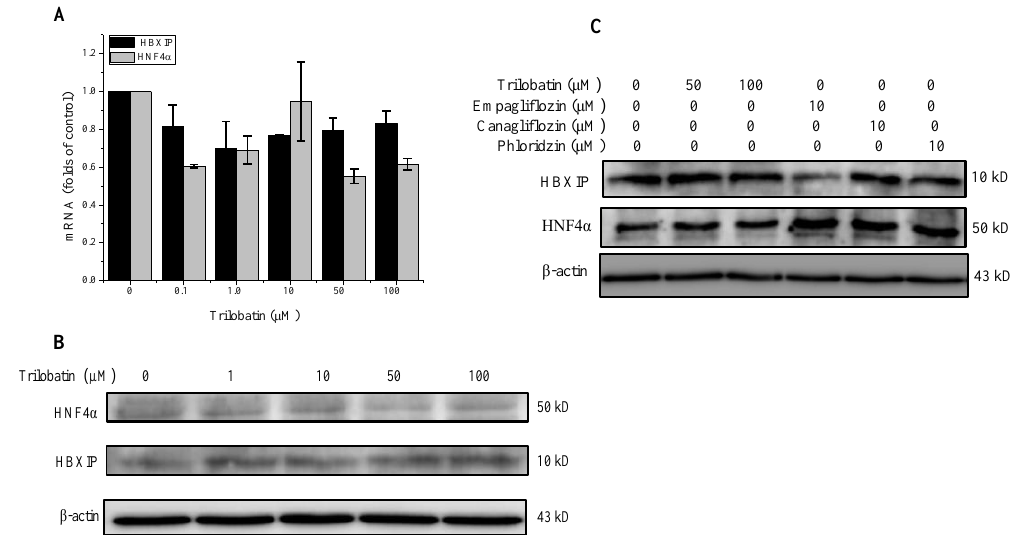
Figure 5. E ff ects of trilobatin on the expression of HBXIP and HNF4 α in HepG2 cells. ( A ) After HepG2 cells were treated with indicated dose of trilobatin for 24 h, the mRNA of HBXIP and HNF4 α were measured by RT-PCR, Data are mean ± SD ( n = 3). ( B ) After HepG2 cells were incubated with indicated concentrations of trilobatin for 24 h, the protein levels of HBXIP and HNF4 α were detected with western blot. ( C ) After HepG2 cells were incubated with indicated concentrations of trilobatin, canagliflozin, empagliflozin and phloridzin for 24 h, the cell lysates were used to determine the protein levels of HBXIP and HNF4 α by western blot.